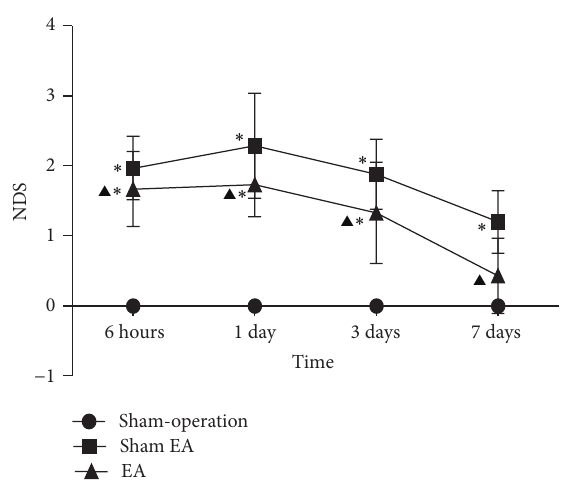
Figure 1: Effects of EA on neurological deficits after ICH in rats (mean ± SD, 𝑛 = 24 ). NDS in Sham-operation group, Sham EA group, and EA group at 6 h, 24 h, 3d, and 7 d. One-way analysis of variance (ANOVA) was used for multiple group experiments comparison and followed by Dunnett test for comparison of two groups within the multiple groups. ∗ 𝑃 < 0.05 , compared with Sham- operated group. 󳵳 𝑃 < 0.05 compared with Sham EA group.